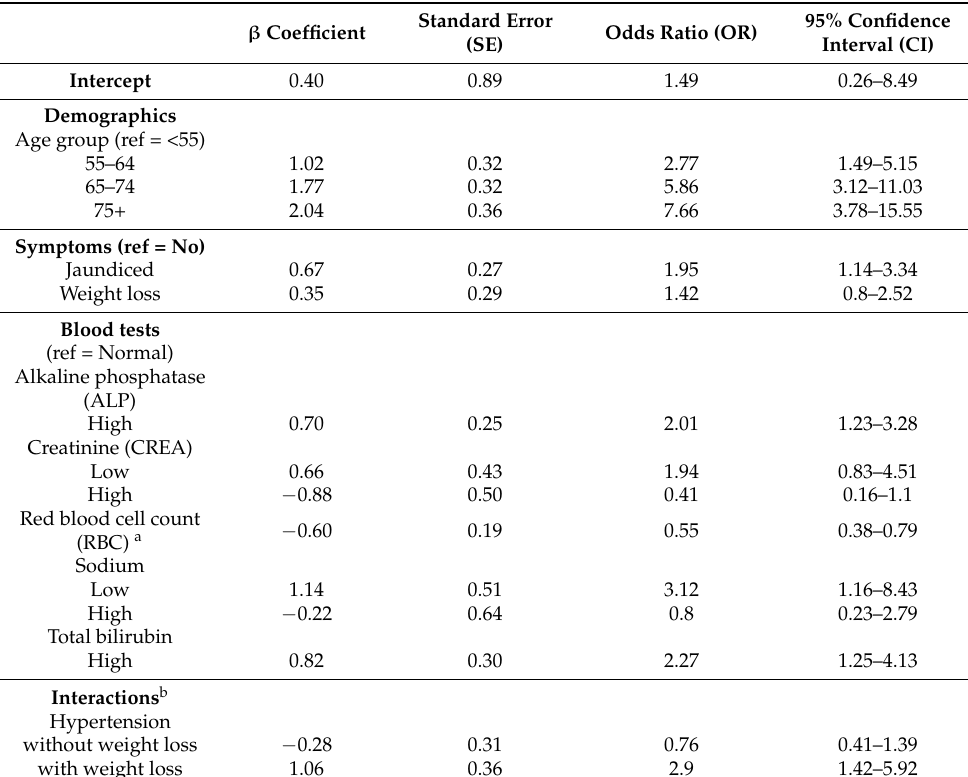
Table 2. Composition of the final PDAC risk prediction algorithm based on logistic regression with stepwise model selection by backward elimination utilising Akaike Information Criterion